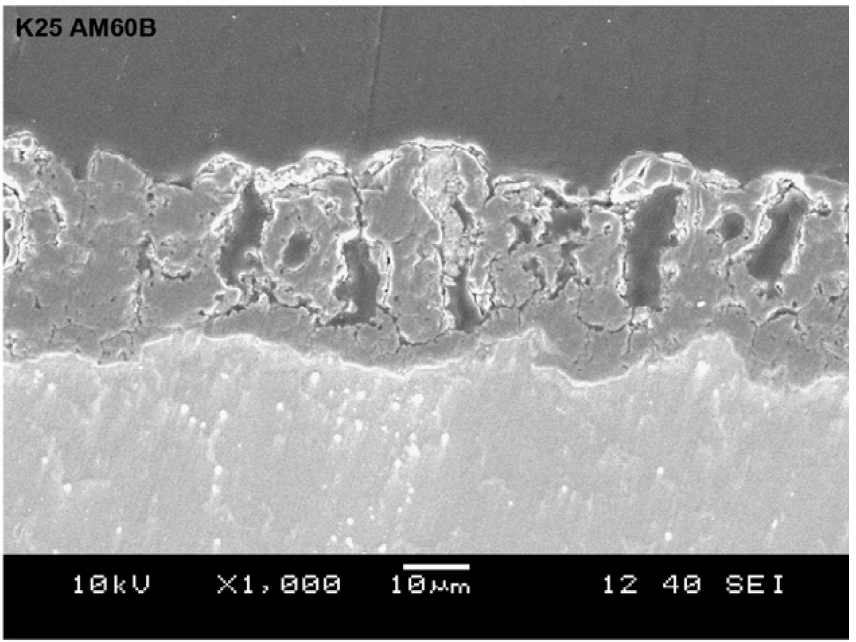
Figure 9. Cross-section SEM image of a 25 µm-thick Keronite coating on die cast AZ91D. Reprinted from [86] with permission from Elsevier.